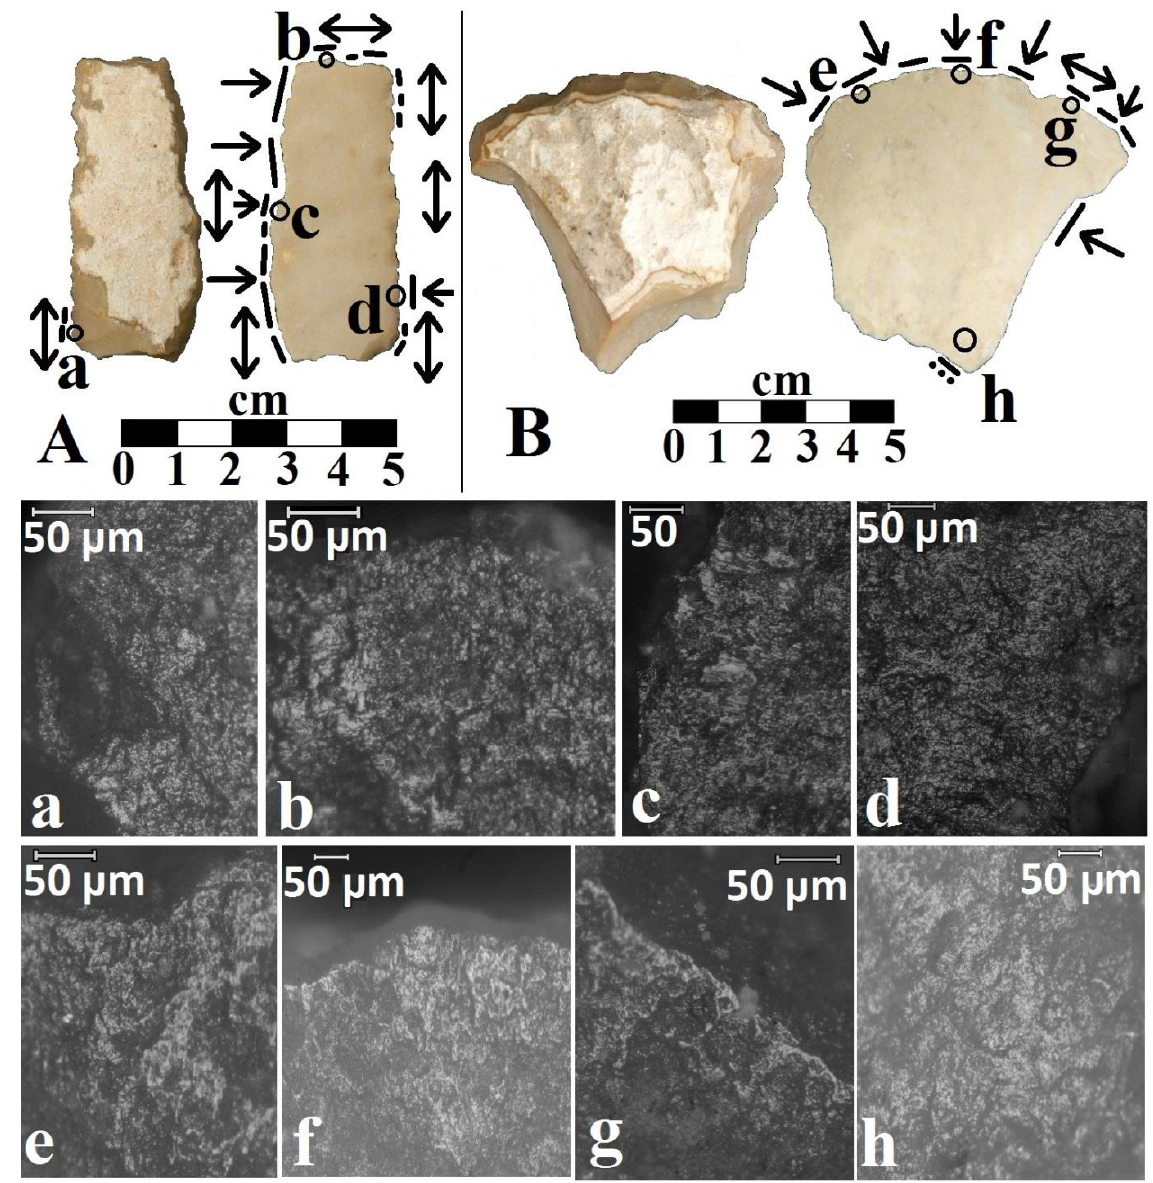
Figure 5. Fan scrapers ( A , B ) used to saw, cut, and scrape bone, meat, and fresh hide. a : bright bone and rough “greasy” fresh hide or meat cutting microwear. c , d , e , f : bright bone and rough “greasy” fresh hide or meat scraping wear. b , g : bright bone with striations and rough meat or hide wear from sawing. h : prehension traces. Sharp edges ( a , d ) used for cutting and scraping, moderate edges ( b , c, e-g ) used for scraping and sawing. A : Dorsal (left) and ventral (right) faces of elongated CFS fan scraper (MW#3) Area B, EBA layer, Locus 1427, Bucket 13471(#2). B : Fan scraper fragment (MW#6) Area B, late PN layer, Locus 3561, Bucket 15133. White lines: extent of usewear, line with dots: prehension traces, arrows show orientation of microwear polishes and striations, Circles: locations of microphotographs a - h. All photomicrographs 187.5x, scales are 50